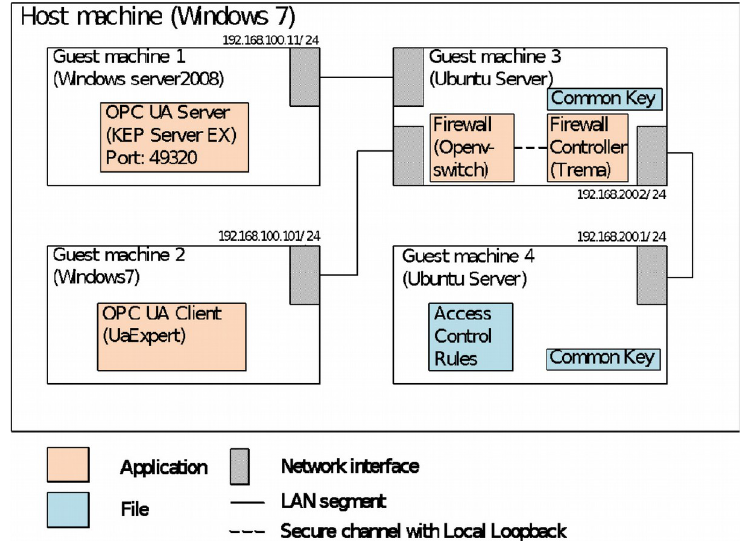
Figure 7. Prototype implementation structure